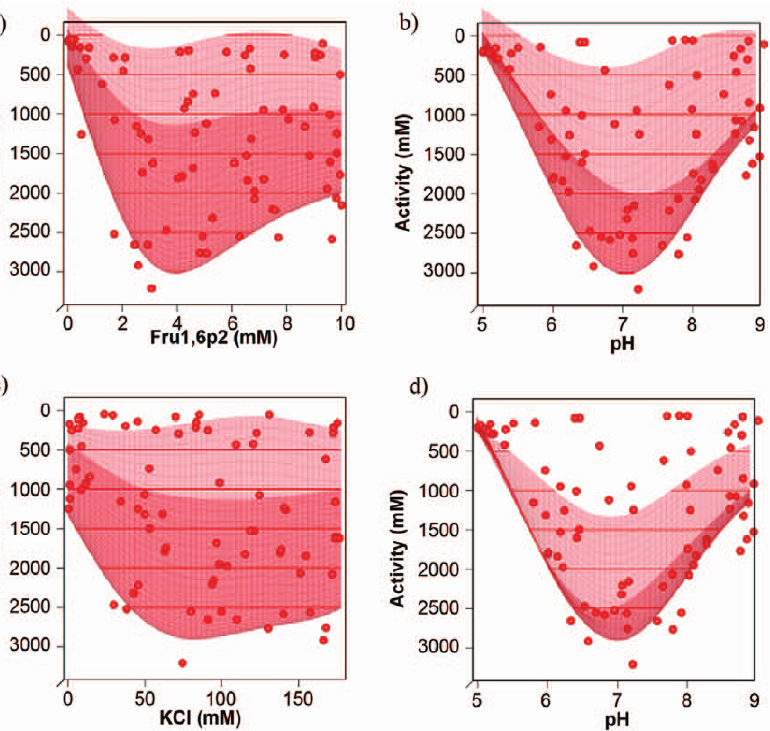
Figure 2. KCl, Fructose 1,6-bisphosphate and pH dependence of PYK activity. Each dot corresponds to a measurement conducted with one of 80 conditions from the space filling design of the first round of the experiment described in 3.2. The four plots show two slices along different axes of the parameter space from two different perspectives. In plot a) and b) the KCl concentration is held fixed at its optimum of 90.6 mM while Fructose 1,6-bisphosphate concentration and pH are variable, in plot c) and d), the Fructose 1,6-bisphosphate concentration is held fixed at its optimum of 4.1 mM with variable KCl concentration and pH. In all plots, the corresponding slice through the Kriging model fitted to the data is shown as a surface.